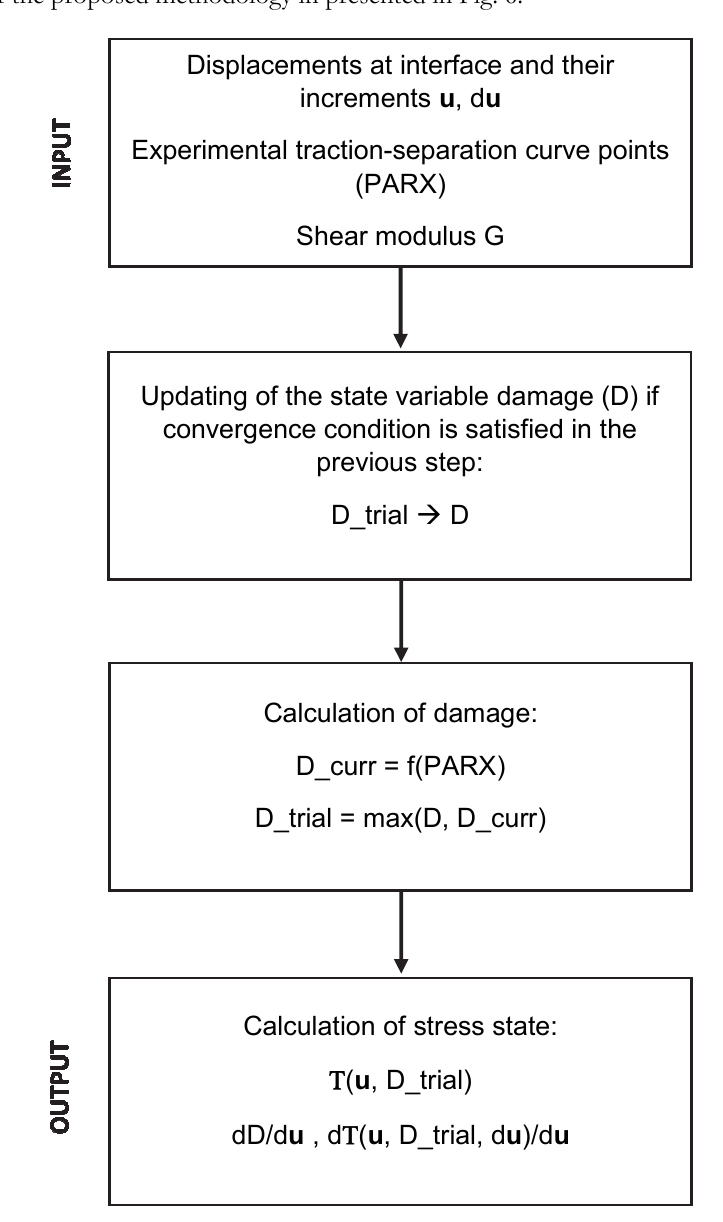
Figure 6: Overall schematic of algorithm, to be repeated until the convergence over u is